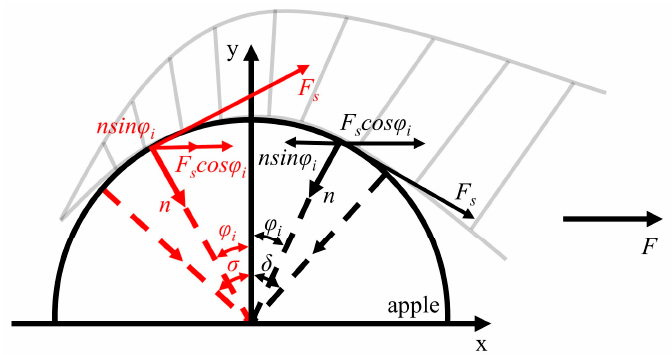
Figure 9. Plane force model of fruit (the forces are shown in red when the load divisions on the x-axis are in the same direction as the x-axis and black in the opposite direction).